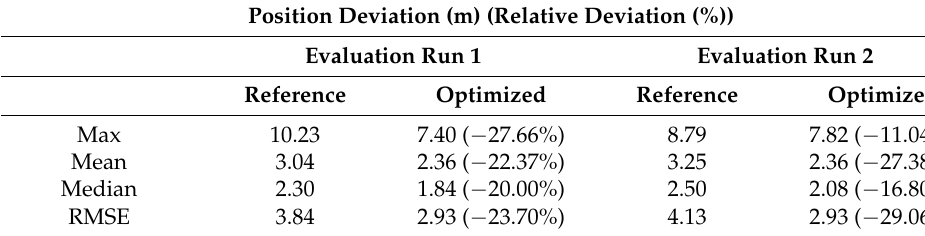
Table 4. Characteristics of the LG evaluation runs.